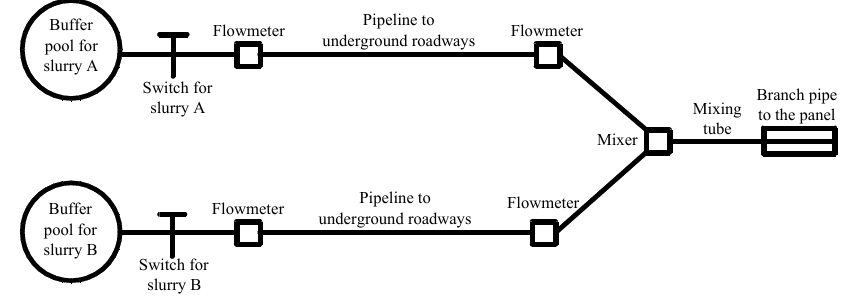
Figure 19. Schematic diagram of transportation of high-water-content backfill materials.